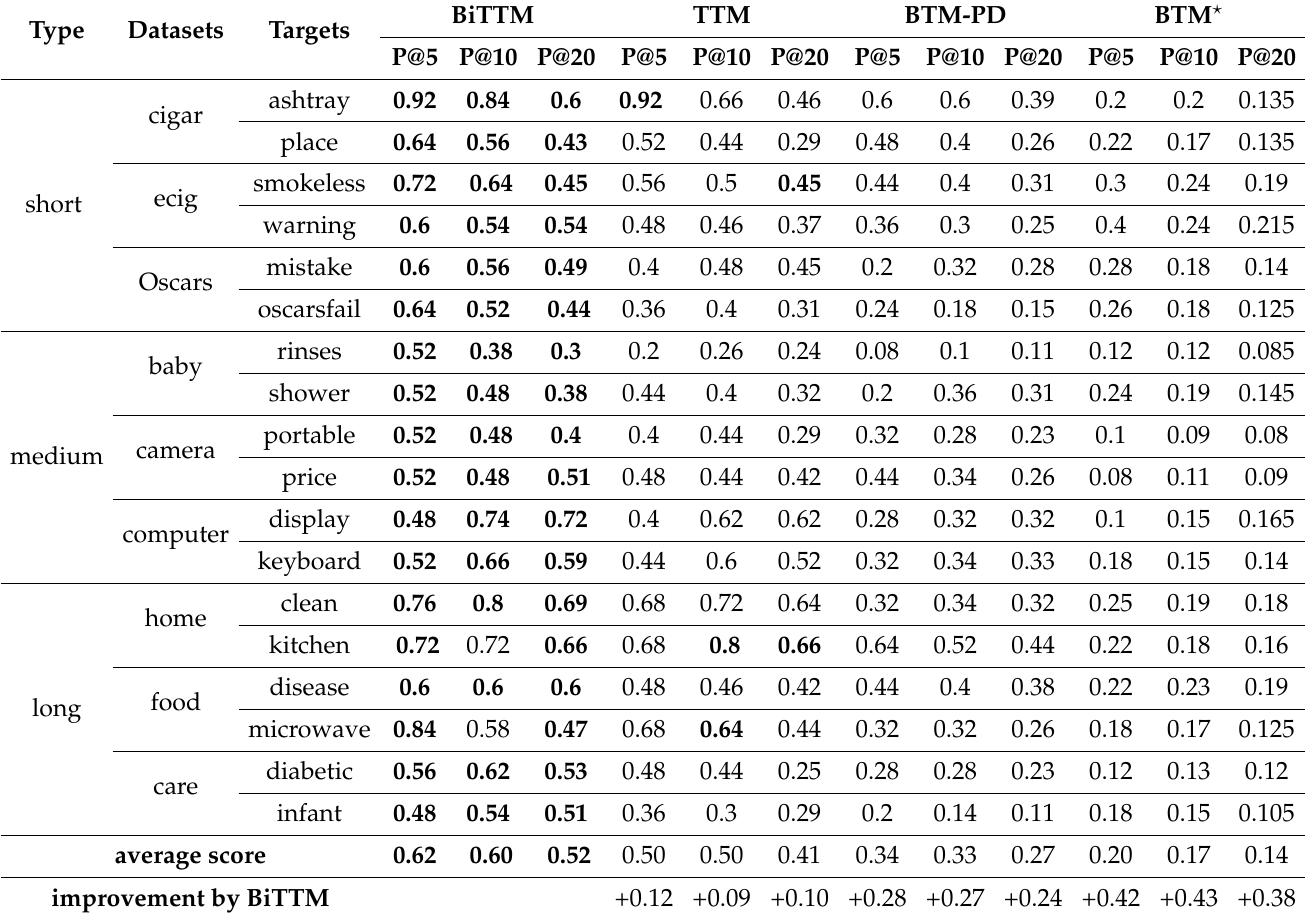
Table 5. P @ n scores of all models over a set of 18 targets on 9 data sets. n is set to 5, 10 and